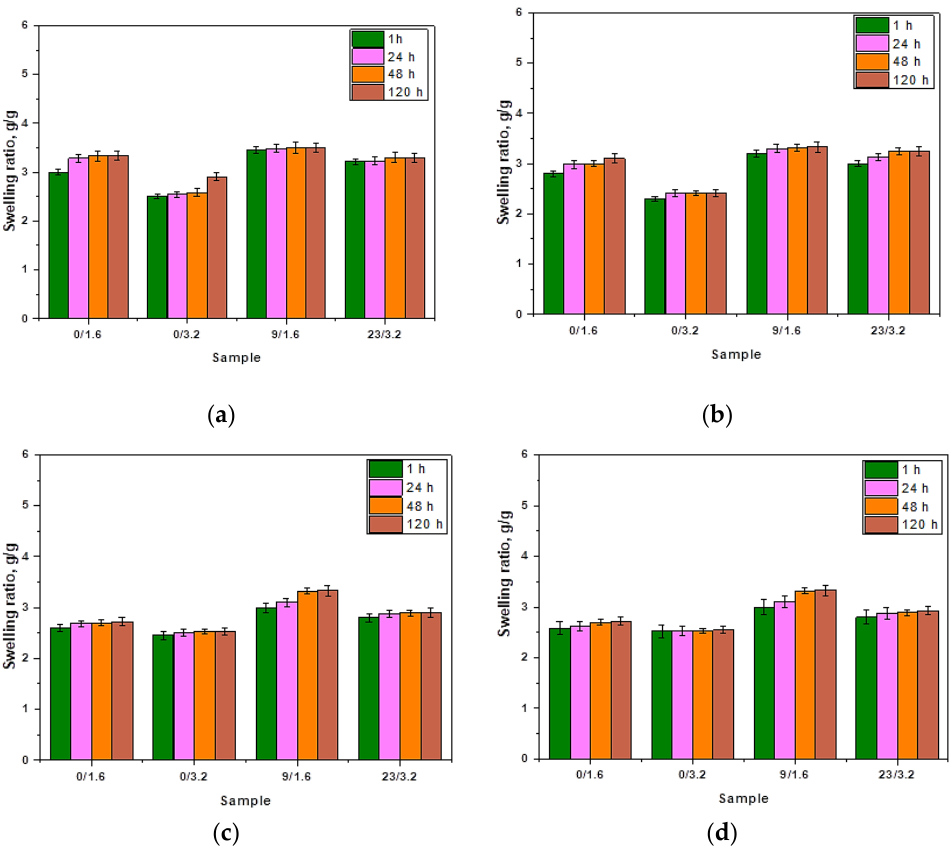
Figure 4. Results of swelling studies of the hydrogels in ( a ) distilled water (average value 𝑆𝐷̅̅̅̅ = 1.20% , number of repetitions n = 3); ( b ) Ringer liquid (average value 𝑆𝐷̅̅̅̅ = 1.40% , number of repetitions n = 3); ( c ) artificial saliva solution (average value 𝑆𝐷̅̅̅̅ = 1.30% , number of repetitions n = 3); and ( d ) in SBF (average value 𝑆𝐷̅̅̅̅ = 1.15% , number of repetitions n = 3).